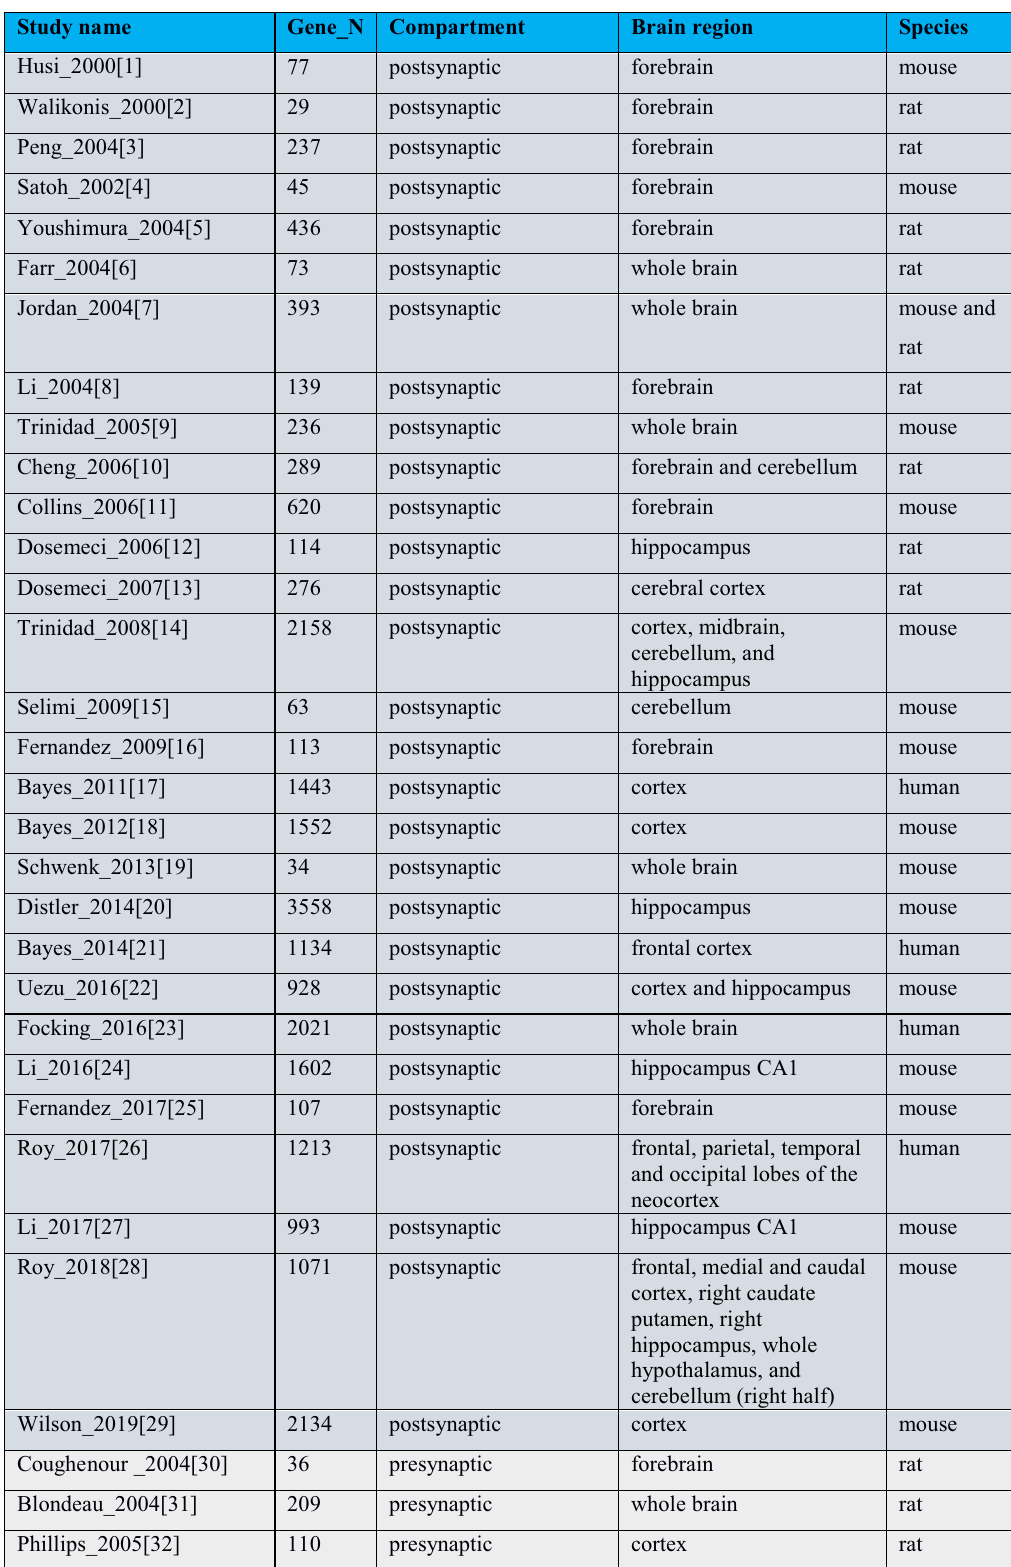
Table 1. Studies included in the database. Dark grey corresponds to postsynaptic, light grey—to presynaptic, and green—to synaptosomal